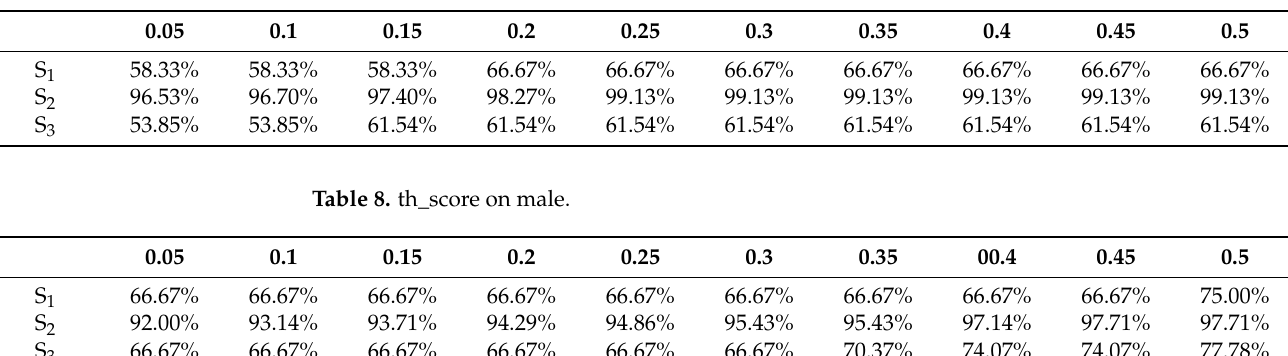
Table 7. th_score on female.